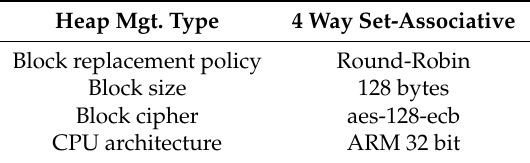
Table 1. Default